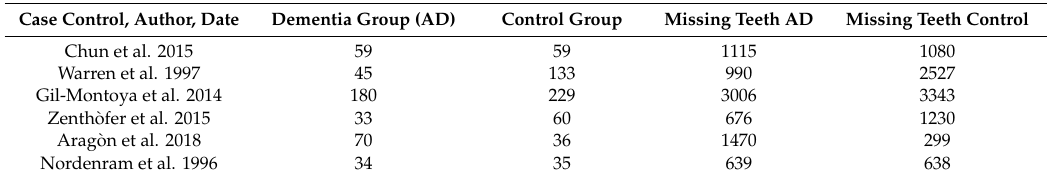
Table 2. Extracted data from selected studies (primary outcome, missing teeth). AD: Alzheimer’s disease.